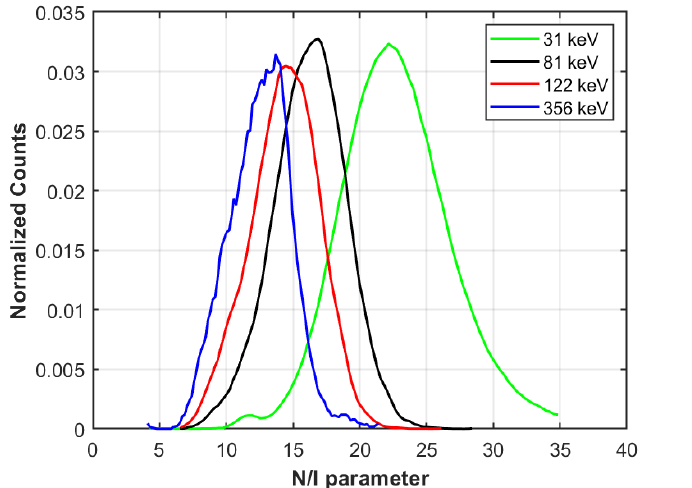
Figure 9. N / I parameter distributions for 31, 81, 122 and 356